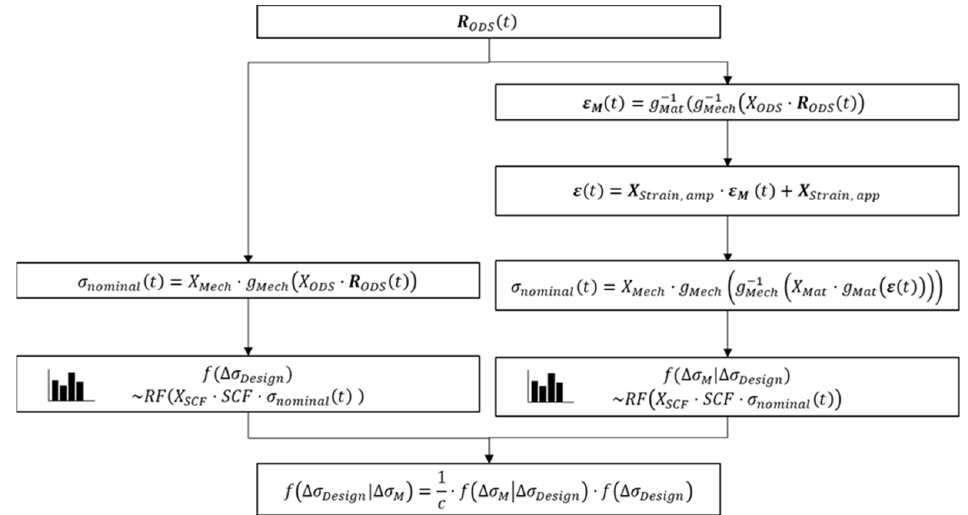
(cid:12) ∆ σ (cid:12) ) . M (cid:12)